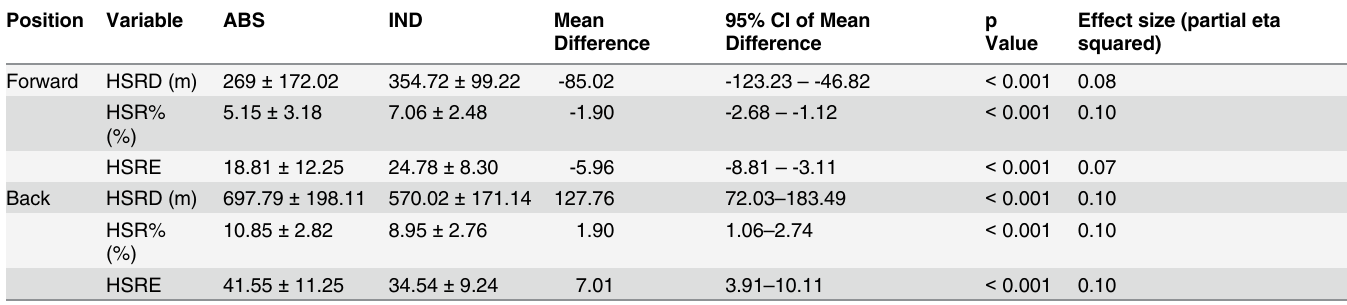
Table 1. ABS vs IND HSR demands of forwards and backs.